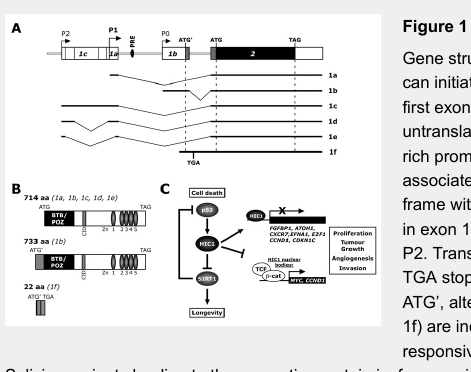
P2. Translation of the unspliced transcript 1f starts at ATG’ within exon 1b, but contains a TGA stop codon in the unspliced intron sequence. Possible translational starts (ATG; ATG’, alternative start codon of 1b and f) and stops (TAG; TGA, stop codon of unspliced 1f) are indicated. Black and grey colouring represents translated exons. PRE, p53 responsive element. ( B ) Functional protein domains of HIC1 and possible HIC1 isoforms. Splicing variants leading to the respective protein isoform are indicated. Transcript 1b could encode an alternative protein containing